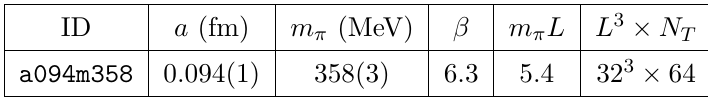
Table 1 . Characteristics of the ensemble used in this